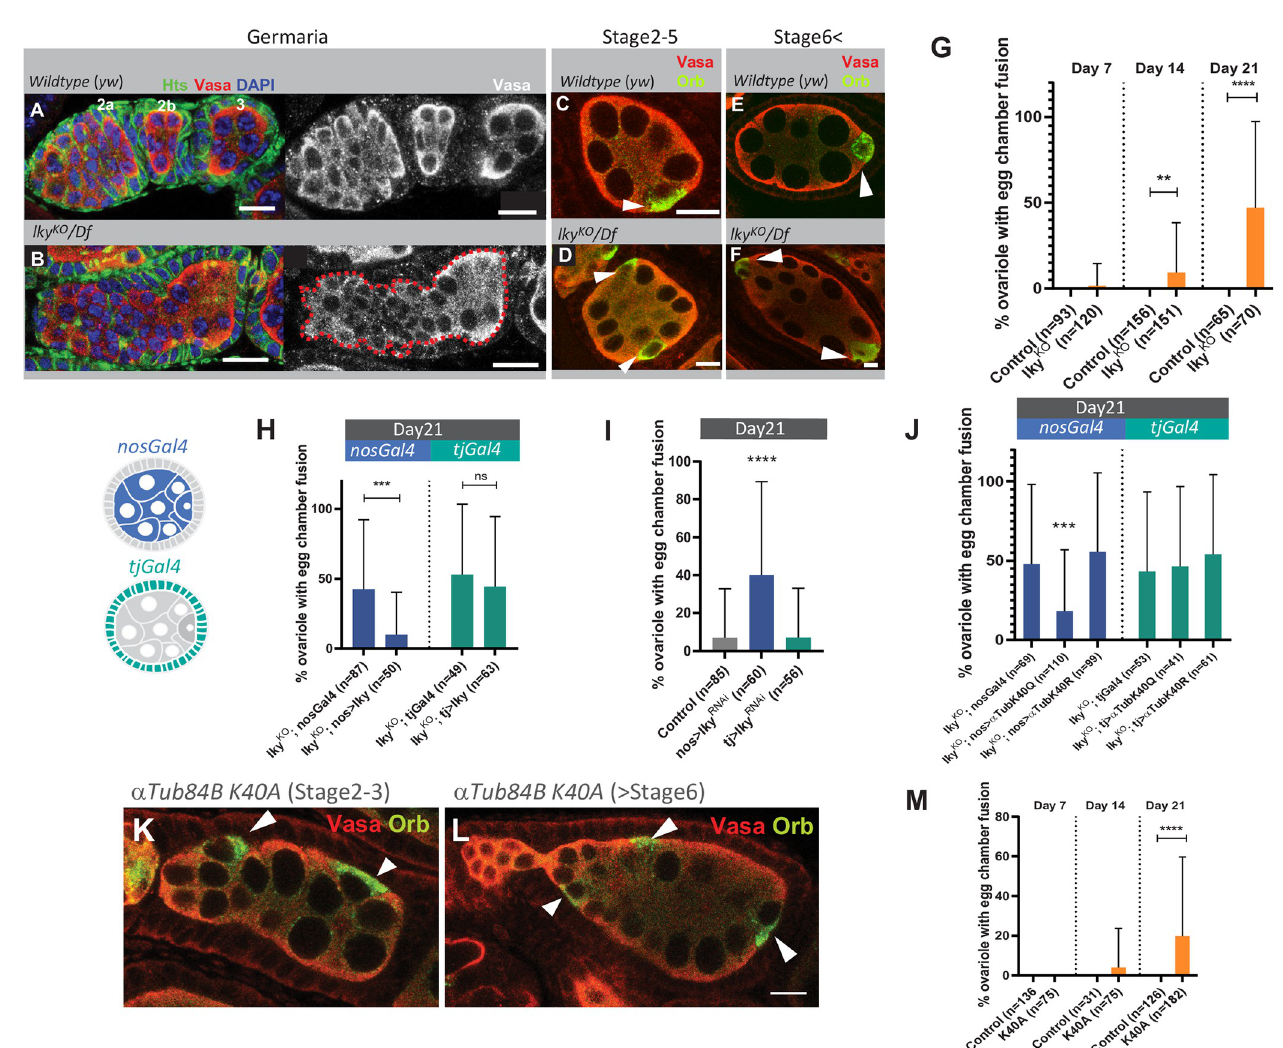
Fig 2. α -K40-acetylation by Lky is required for maintenance of oogenesis during fly aging. A-F ) Representative images for comparison of wildtype ( yw , A, C, E ) and lky KO ( lky KO /Df , B, D, F ) ovarioles, showing the egg chamber fusion phenotype in lky KO . White arrowheads in C-F indicate oocytes (Orb, green) in indicated stages of egg chambers of wildtype ( C, E ) and lky KO ( D, F ). G ) A graph shows frequency of ovarioles with egg chamber fusion, scored at 7, 14, and 21 days post-eclosion for the indicated genotypes. H ) A graph shows frequency of ovarioles with egg chamber fusion in lky KO with or without germline ( nosGal4 driven)- or somatic cell ( tjGal4 driven)- specific expression of lky . I ) A graph shows frequency of ovarioles with egg chamber fusion in ovaries of lky RNAi induced under the germline ( nosGal4 )- or somatic cell ( tjGal4 ) drivers. J ) A graph shows frequency of ovarioles with egg chamber fusion after germline ( nosGal4 driven)- or somatic cell ( tjGal4 driven)- specific expression of α Tubulin K40Q or α Tubulin K40R transgenes. Flies were used at day 21 post-eclosion for H-J . K-L ) Representative images of α Tub84B K40A homozygous knock-in ovarioles showing egg chamber fusion at indicated stages. Flies were used at day 21 post-eclosion. M ) A graph shows frequency of ovarioles with egg chamber fusion in α Tub84B K40A knock-in ovaries at indicated ages. Heterozygous flies ( α Tub84B K40A /+ ) were used for the control. Adjusted P values from Sˇida´k’s multiple comparisons test are shown for G, H, and J, and Dunnett’s multiple comparisons test for I. For all data points, a minimum of 20 ovaries were used from two individual crosses. Scale Bars: 10 μ